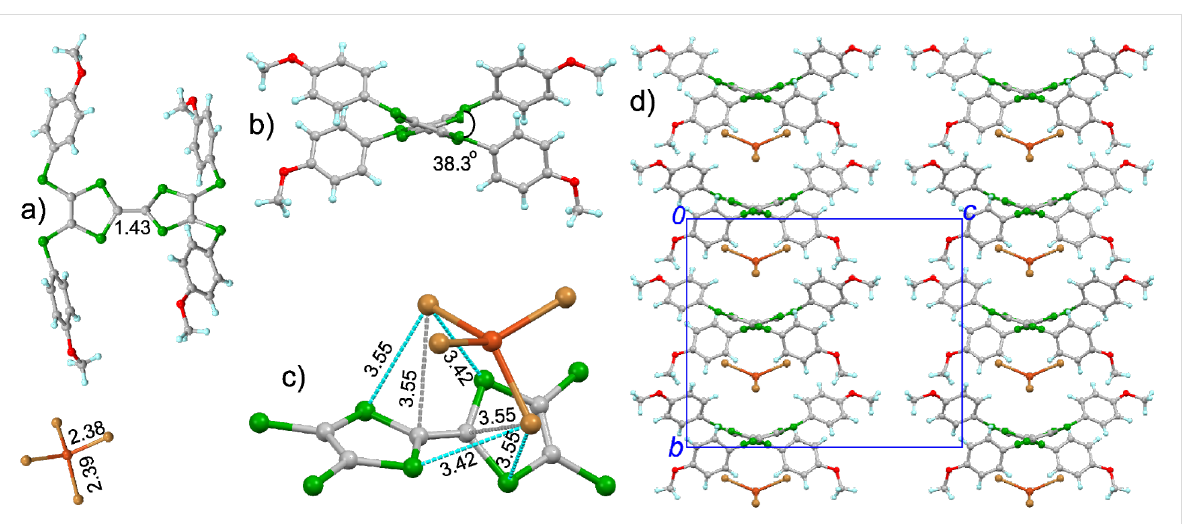
Figure 3: Crystal structure of 4 ·CuBr 4 : a) unit cell contents with the typical bond lengths shown (Å); b) view of molecule 4 along the central C=C bond of the TTF core, and the dihedral angle between two C 3 S 2 rings is shown; c) interaction between the [Cu(II)Br 4 ] 2 − ion and the central TTF core of 4 , where cyan and grey dashed lines represent Br ··· S and Br ··· C contacts (Å), respectively; d) packing structure viewed along the a -axis.